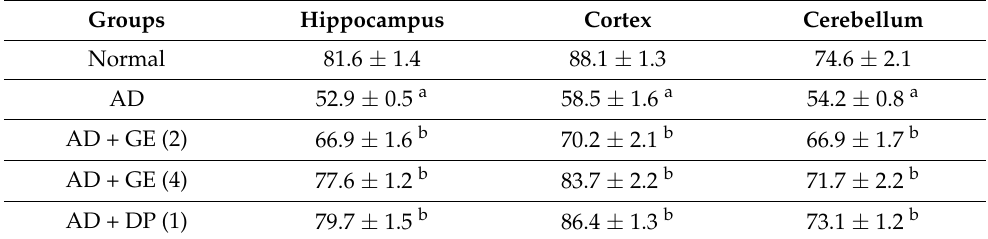
Table 3. Effect of GE on the changes in GSH levels in brain tissue